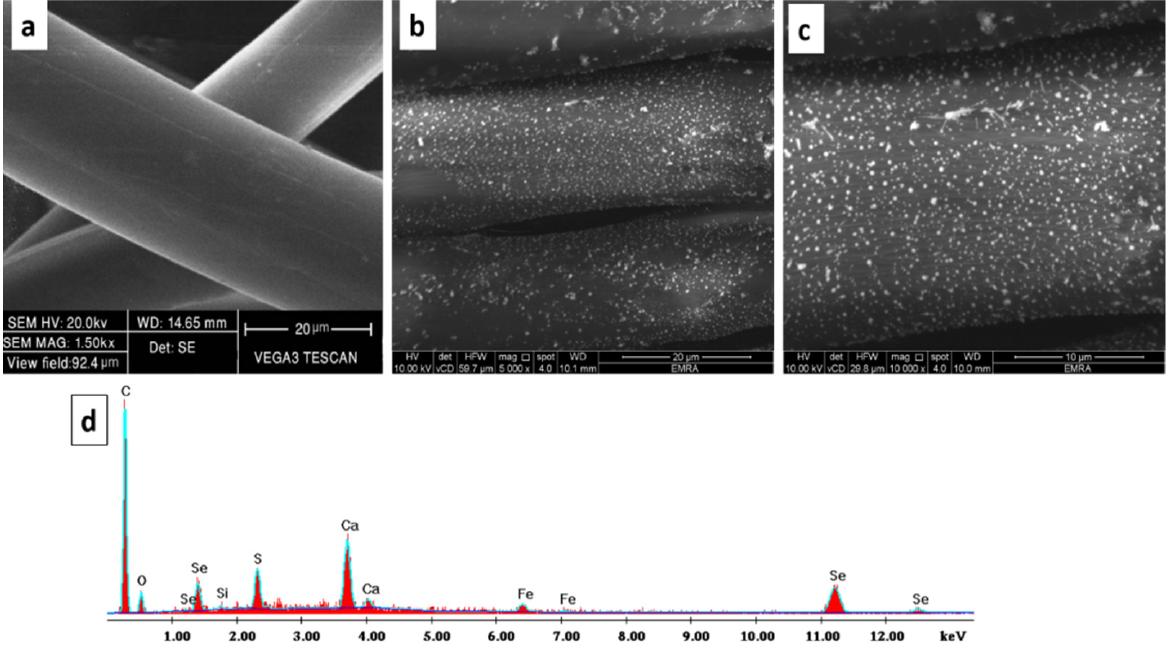
Figure 4. SEM micrographs of ( a ) the PP fabric, ( b , c ) SeNPs-PP fabric, ( d ) EDX analysis of the SeNPs-PP fabric.